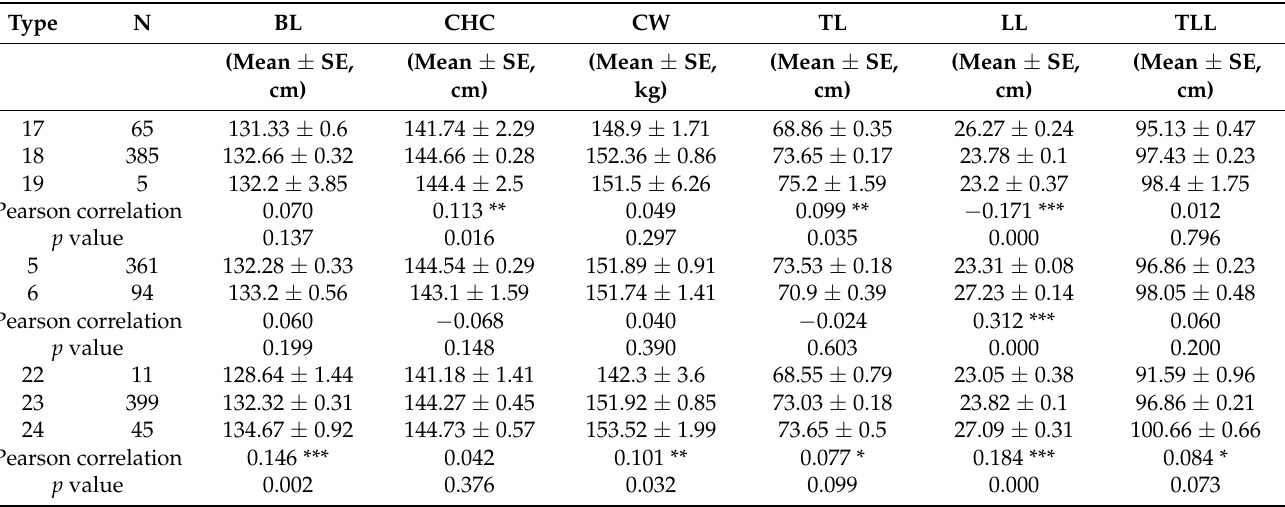
Table 2. The association analysis of TN, LN, and TLN with body size and carcass traits of Dezhou